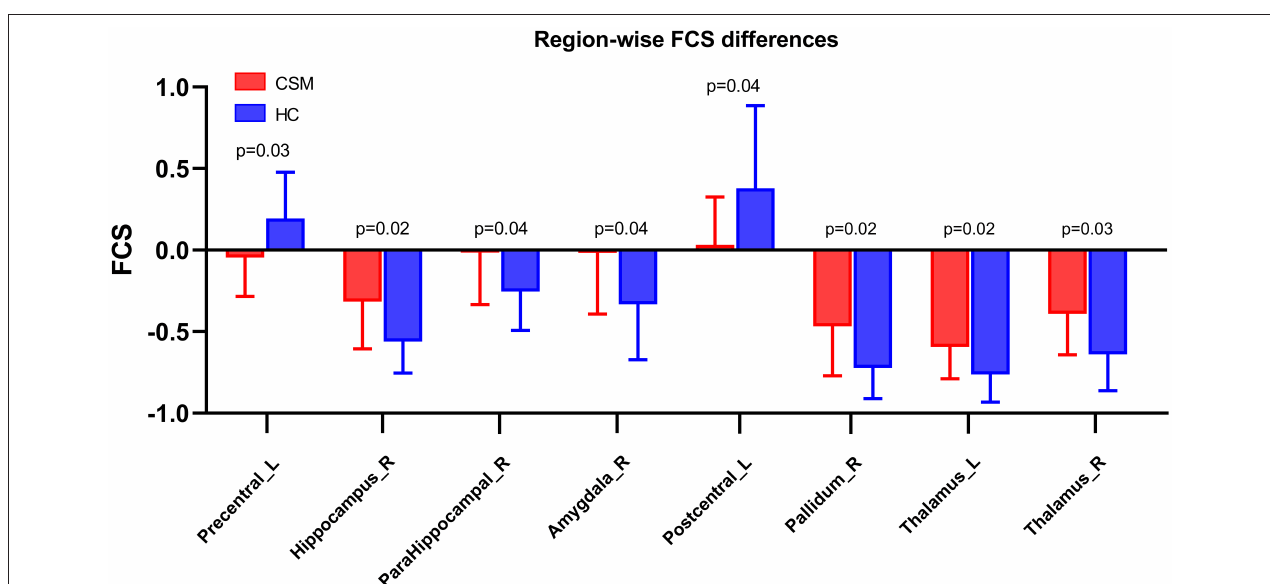
FIGURE 3 | Region-wise CBF–FCS coupling changes in cervical spondylotic myelopathy (CSM) patients based on AAL. FCS was significantly different between CSM patients and healthy individuals. Error bars represent the SD, FDR-corrected p -values are shown above bars. CBF, cerebral blood flow; FCS, functional connectivity strength; Precentral_L, Left precentral gyrus; Hippocampus_R, Right hippocampus; ParaHippocampal_R, Right parahippocampus; Amygdala_R, Right Amygdala; Postcentral_L, Left postcentral gyrus; Pallidum_R, Right pallidum; Thalamus_L, Left Thalamus; Thalamus_R, Right thalamus.